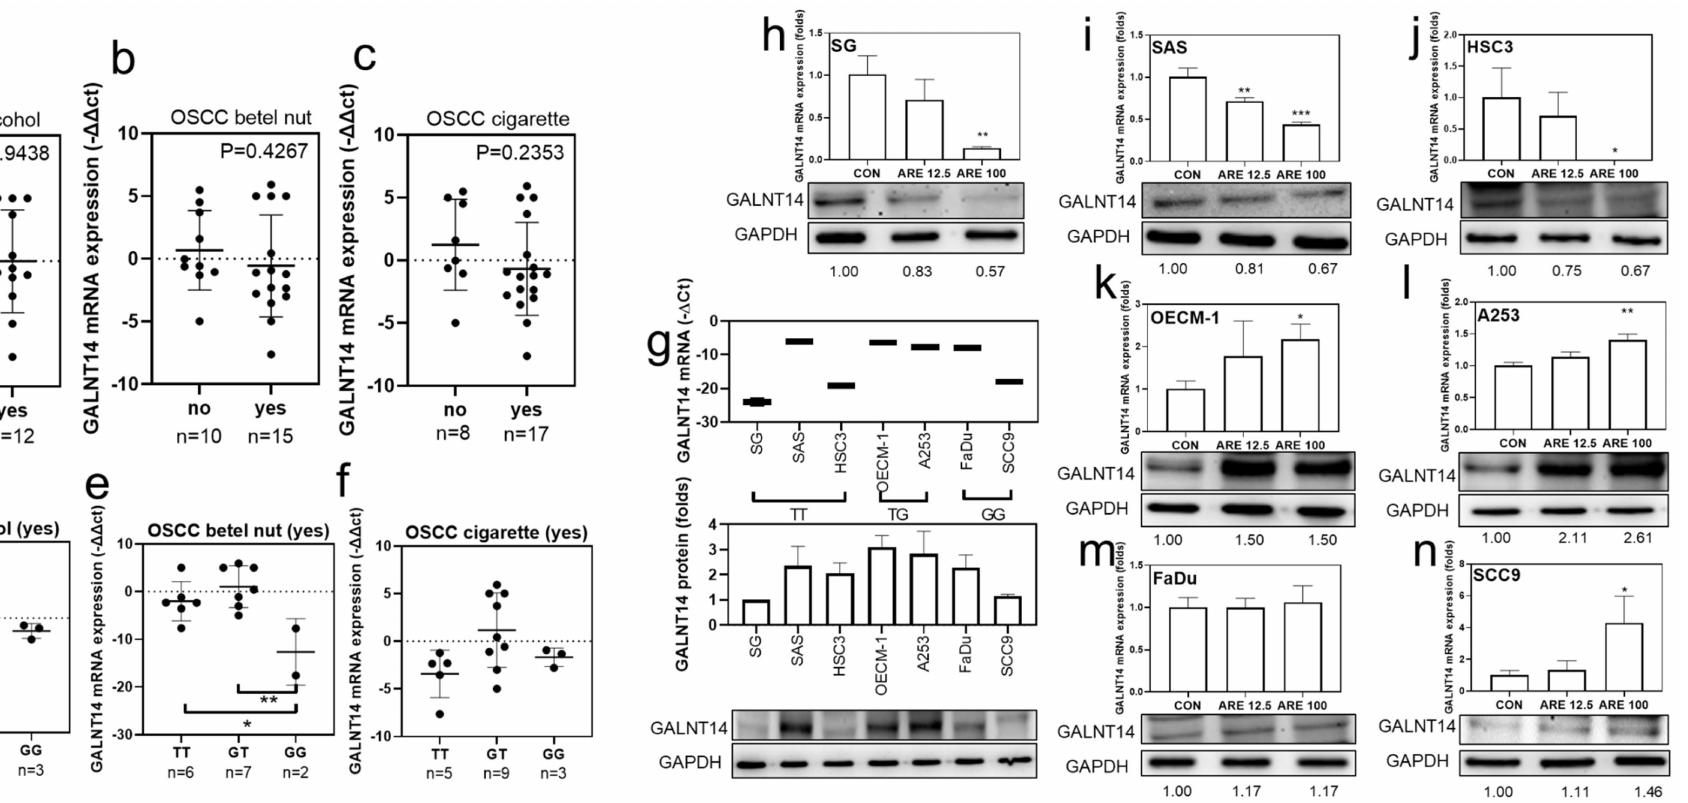
Figure 4. Relation between OSCC risk factors and GALNT14 -rs9679162 genotype or GALNT14 mRNA expression in OSCC. ( a ) GALNT14 mRNA expression levels (circle, − ∆∆ Ct of each paired tissue; black lines, mean ± SD) with respect to alcohol consumption, ( b ) betel nut chewing, and ( c ) cigarette smoking in OSCC patients. ( d ) GALNT14 mRNA expression in the GALNT14 -rs9679162 genotypes in alcohol drinking, ( e ) betel nut chewing, ( f ) cigarette smoking OSCC patients. ( g ) GALNT14 mRNA ( − ∆ Ct, mean ± SD) and protein expression (folds) levels in seven OSCC cell lines. GALNT14 mRNA and protein expression after treatment with vehicle, 12.5 or 100 µ g/mL arecoline for 24 h in ( h ) SG, ( i ) SAS, ( j ) HSC3, ( k ) OECM-1, ( l ) A253, ( m ) FaDu, and ( n ) SCC9 cell lines. One-way ANOVA was used to analyze the data in ( d – n ). * p < 0.05, ** p < 0.01, *** p <